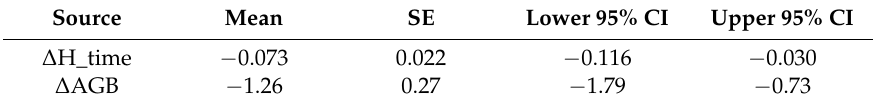
Table 3. Summary statistics and uncertainty for ∆ H_time and ∆ AGB. The mean is derived from the entire population, while the standard error of the mean (SE) and the 95% confidence intervals (CI) are derived from 100 Monte Carlo iterations based on a subsample of 1% of the dataset and rescaled to the mean. Source Mean SE Lower 95% CI Upper 95% CI ∆ H_time − 0.073 0.022